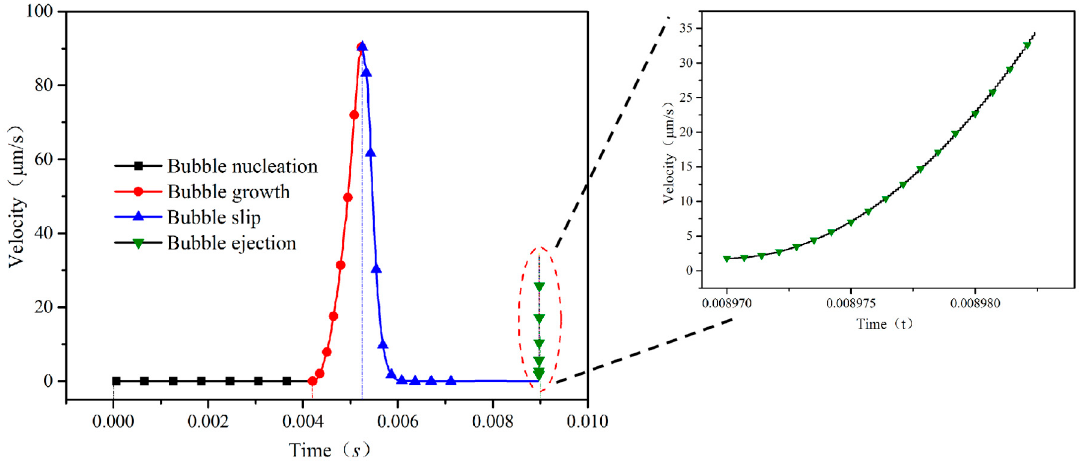
Figure 13. The velocity of the micromotor in the full life-cycles of bubbles, namely bubble nucleation, growth, slip, and ejection. Inset: ejection stage.